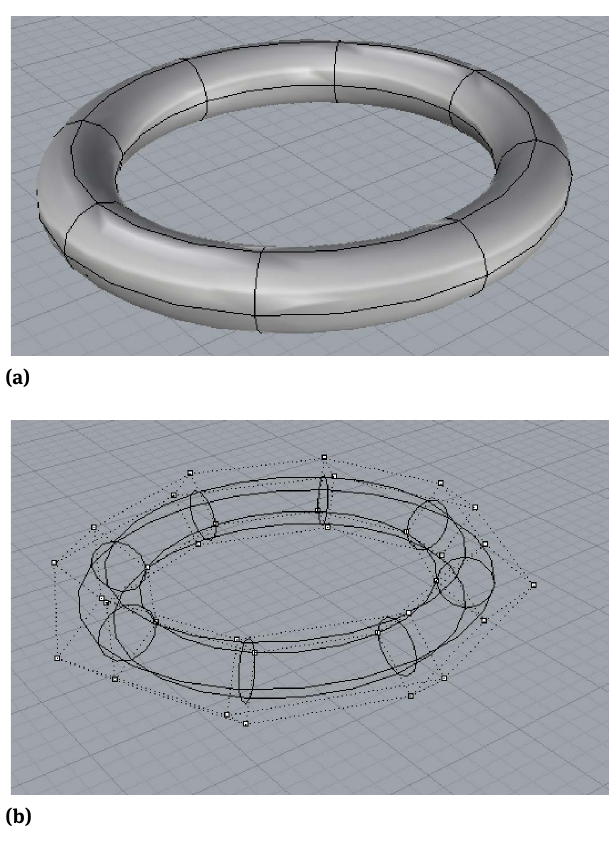
Figure 2: Toroidal geometry: (a) surface, and (b) its control